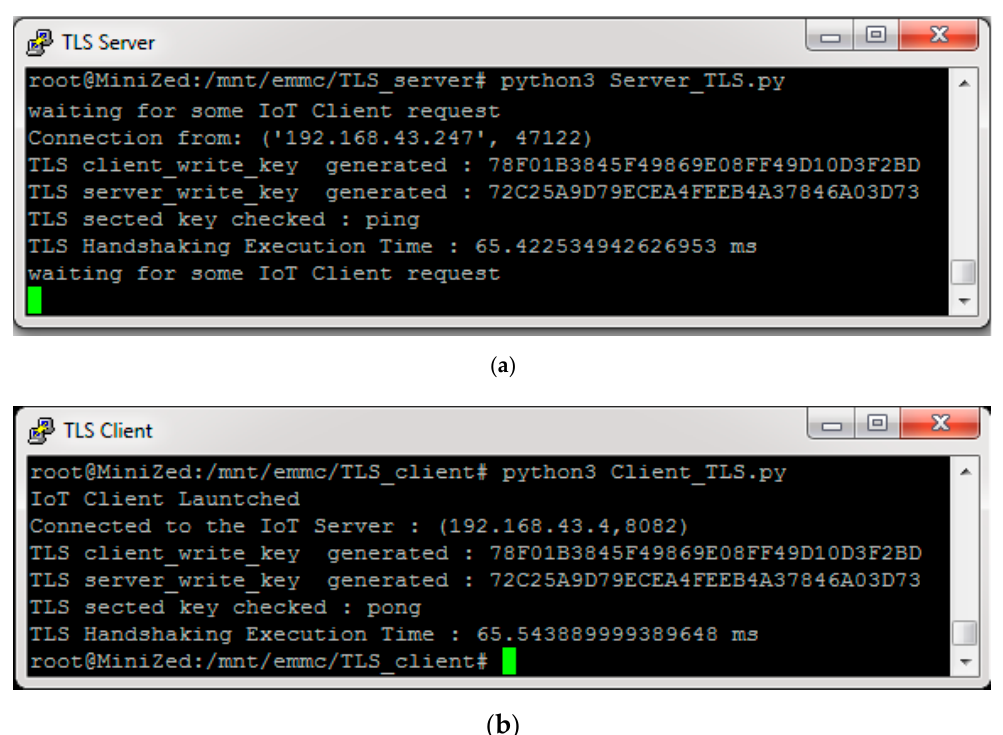
Figure 8. Screenshot of TLS1.2() execution time in the ( a ) server side, and the ( b ) client side.